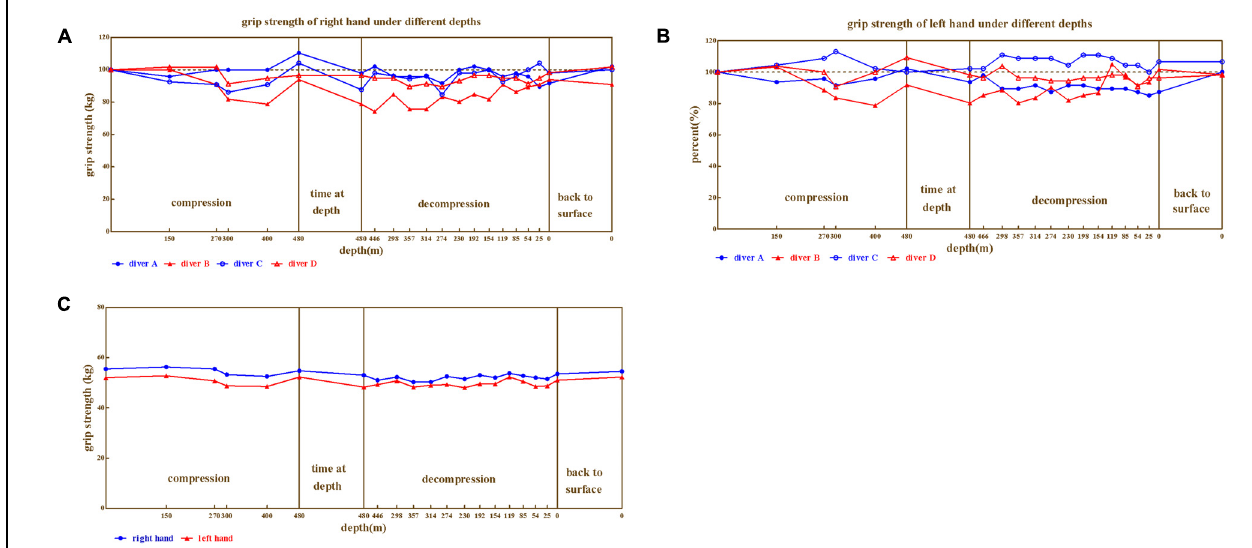
FIGURE 5 | The results from grip strength. (A) Right hand for divers, (B) Left hand for four divers, (C) Left and right hand on average, respectively.